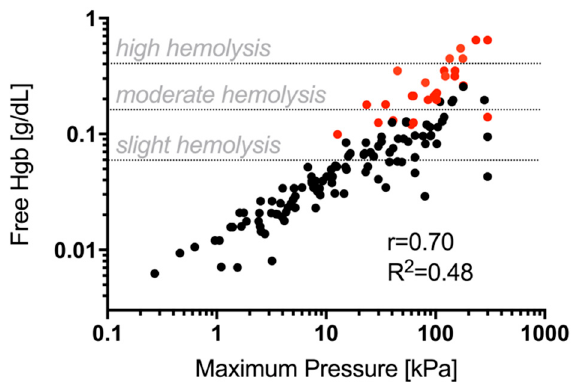
Figure 5. Free hemoglobin represented as a function of maximum pressure recorded. Each point is obtained through the average of at least three independent experiments (n = 3). For clarity we have only highlighted one indicator. The commercial membranes plotted in red, clearly show higher pressure drops and resulting hemolysis. We used Snyder scale of Hgb concentrations of 0.060, 0.150, and 0.300 g dL − 1 corresponding to thresholds for slight, moderate, and high hemolysis [42]. The slight, moderate, and high levels are showed with three horizontal dash lines.